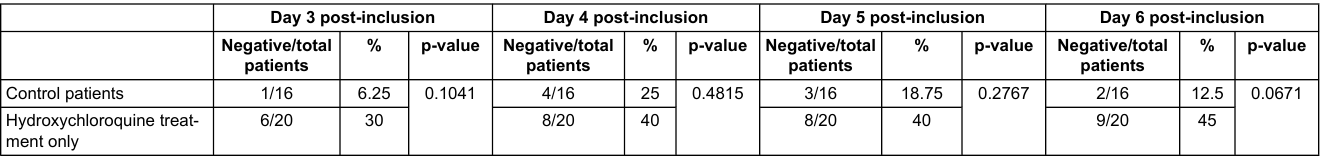
Table S2: Proportion of patients with virological cure in SARS-CoV-2 patients inclusive of all study participants (intention-to-treat design). Day 3